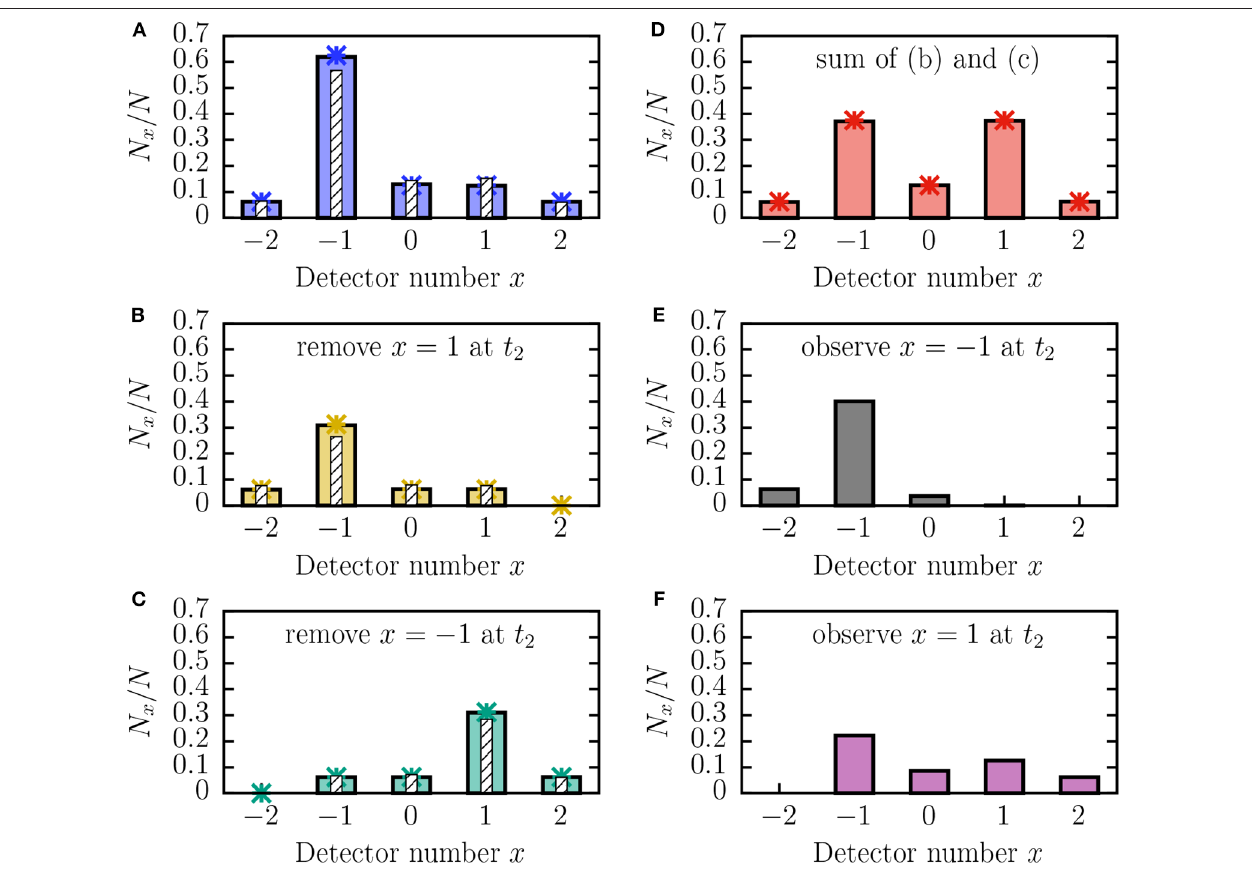
FIGURE 4 | DES results (solid bars) of the normalized detector counts N x / N as a function of the detector position x . In each run, N through the network shown in Figure 3 . In (A–C) , the solid bars represent the distribution where at position t 2 , (A) no particles, (B) particles at x x 1 have been removed. In (D) , the sum of (B,C) is shown to be symmetric and equal to the four-step QW shown in Figure 2C (for x = − distributions resulting from only observing (and not removing) the particle at t 2 . As their sum yields the distribution in (A) , the observation does not affect the result and is thus non-invasive. Asterisks represent the ideal result obtained from quantum theory, i.e., / √ 2 (see also Equations 2–5). There are no asterisks in (E,F) because this information is only accessible in the subquantum model. The corresponding or (C) 1, | + ↓i experimental data presented in Figures 3A–C of Robens et al. [ 1] is (up to a normalization factor) indicated by the striped bars in (A–C)